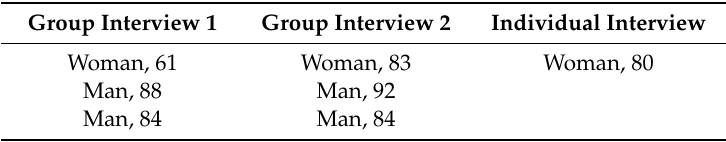
Table 1. Age and sex of the